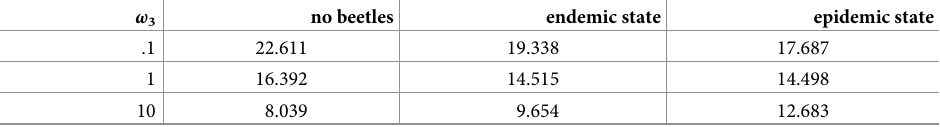
Table 2. Benefit values for optimal control problem P3 for three distinct harvesting cost weight, ω 3 with fixed ω 1 = 1 and ω 2 =